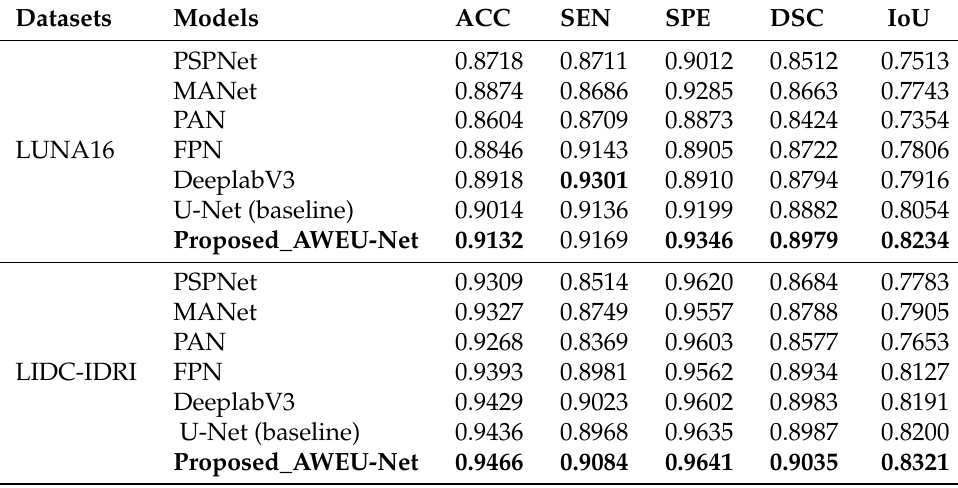
Table 3. Comparison between the proposed AWEU-Net and six other models on the LIDC-IDRI and LUNA16 test datasets (bold represents the best